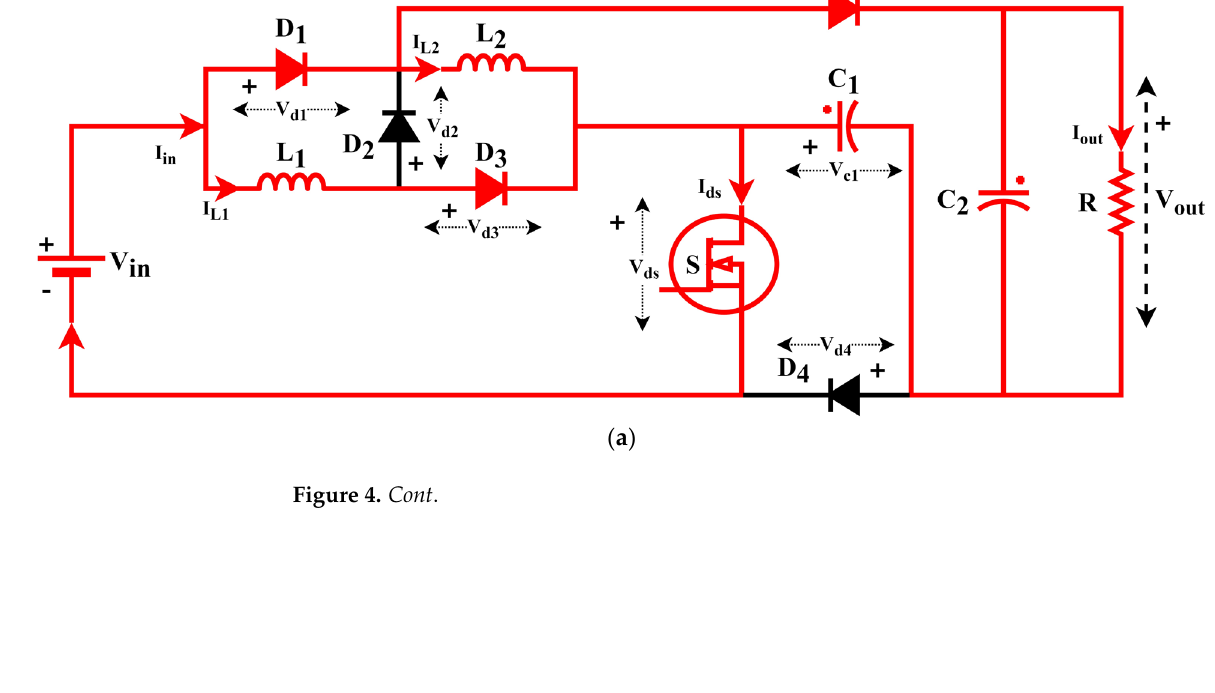
Figure 3. Theoretical waveforms of the MQZS step-up converter.